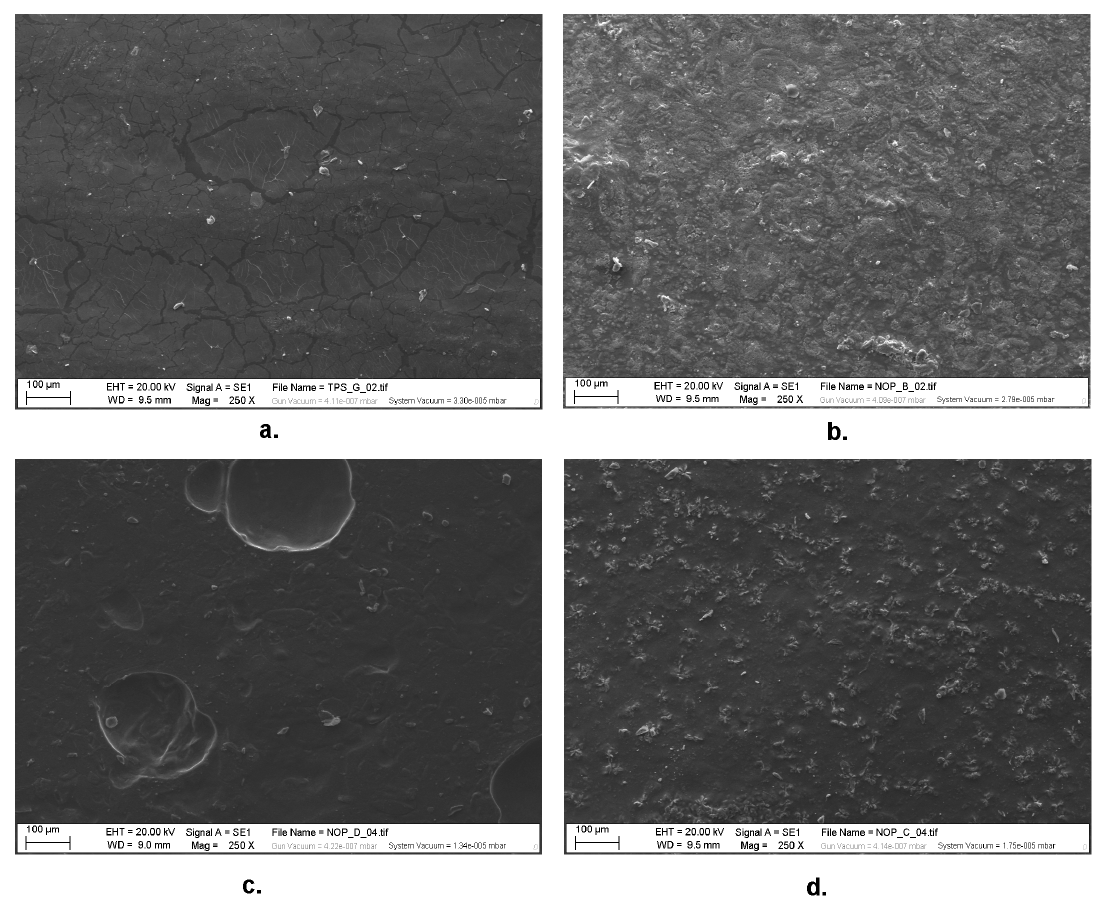
Figure 11. SEM images of TPS film (a.) and its blended films (type MA (b.), type ME (c.) and type MPM (d.)). Magnification: 250×.